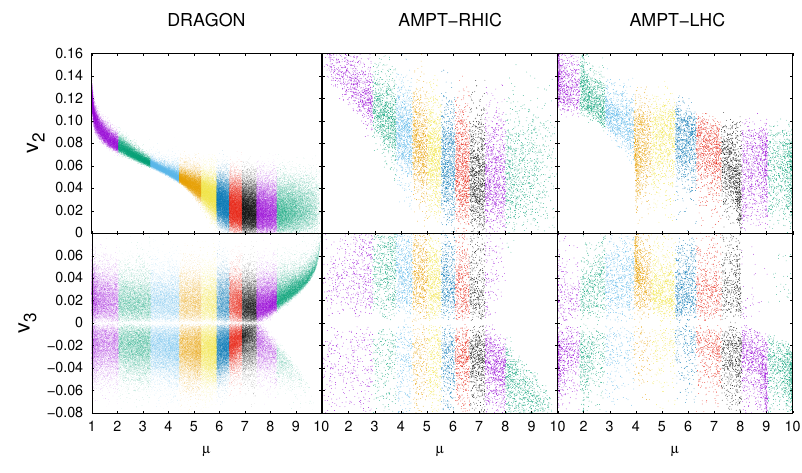
Figure 2. Correlation of the sorting variable µ with v 2 (upper row) and v 3 (lower row) for all events from the sets generated by DRAGON (left column), AMPT for RHIC (middle) and AMPT for the LHC (right). The variable µ is the value according to which the events are ordered. Di ff erent event bins are indicated with di ff erent colours; each dot corresponds to one event